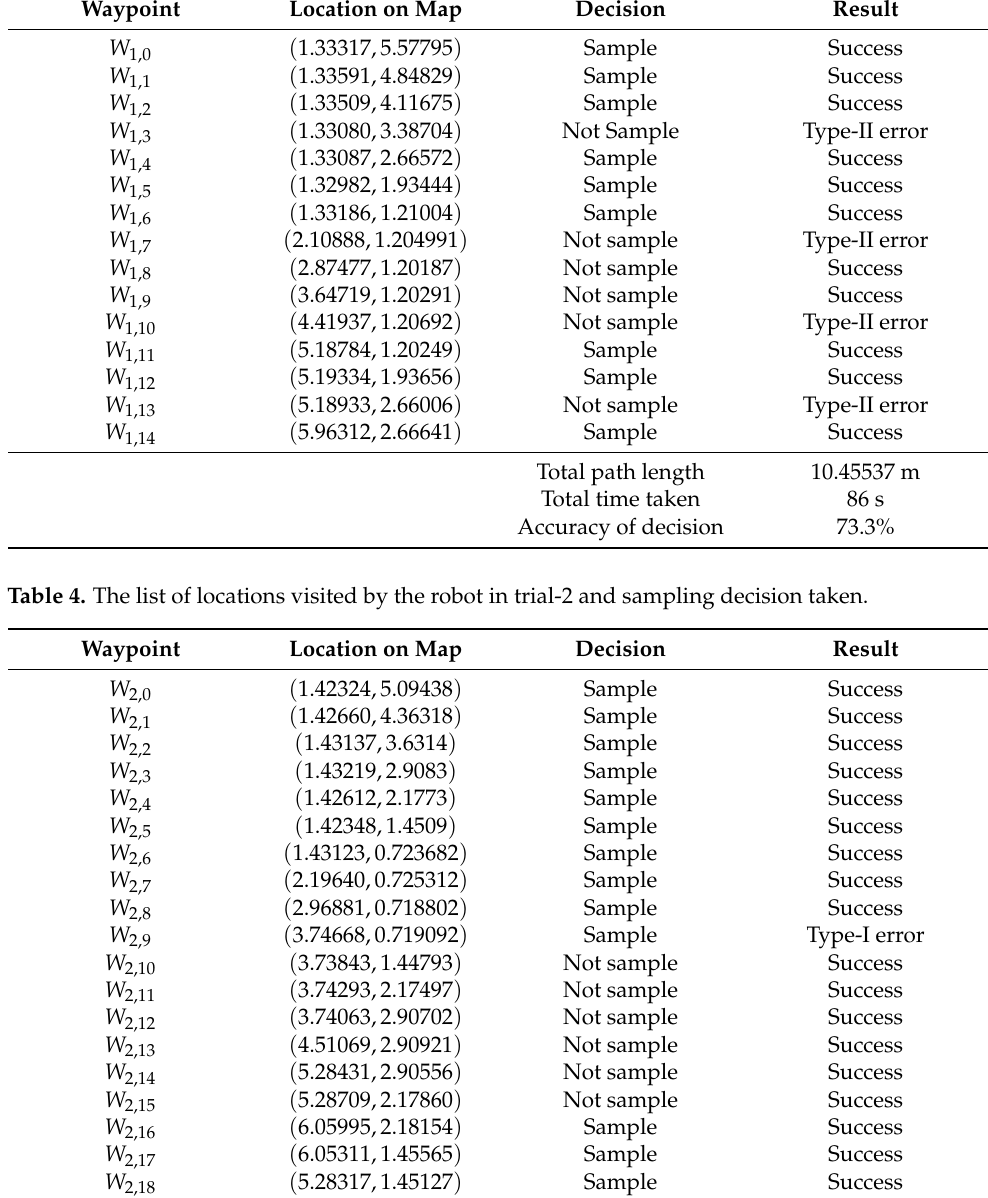
Table 3. The list of locations visited by the robot in trial-1 and sampling decision taken. Waypoint